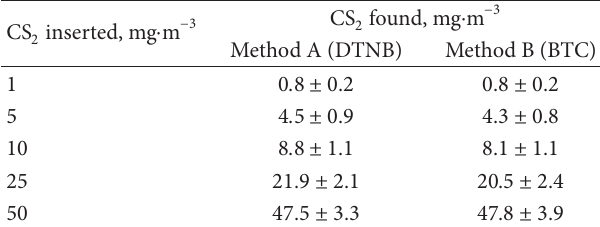
T 2: Verifying of correctness of CS determination in the /reagent 4